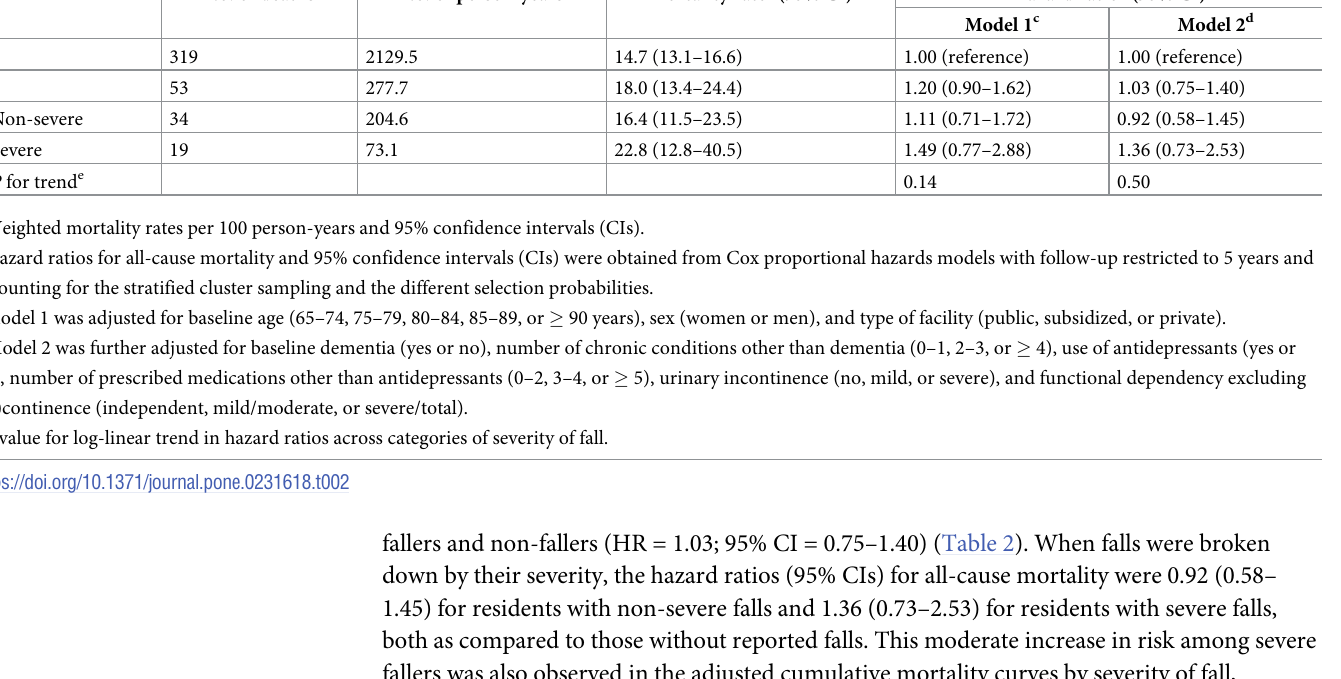
Table 2. Hazard ratios for all-cause mortality by occurrence and severity of fall among nursing home residents in Madrid, Spain.